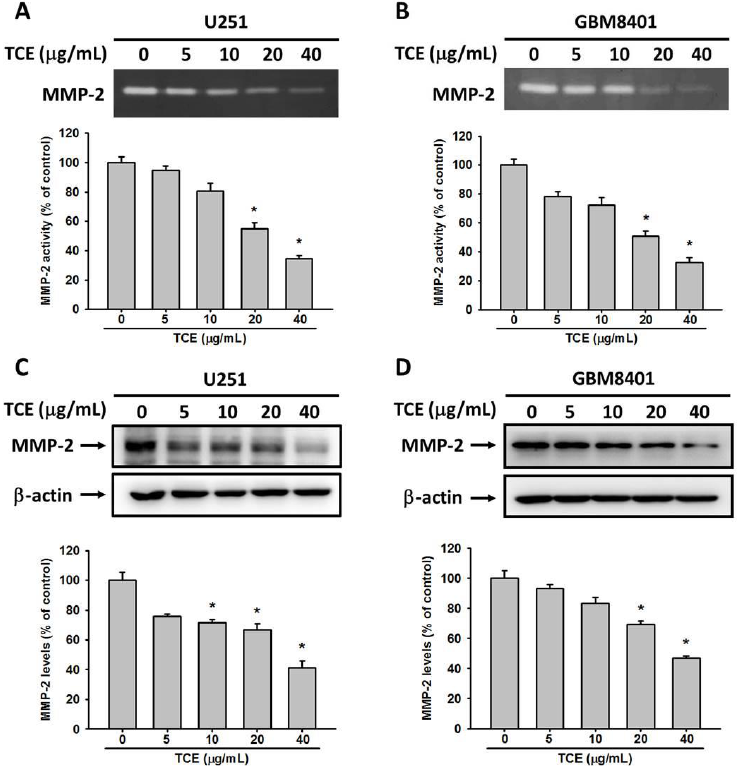
Figure 3. Effects of T. catappa L. extract (TCE) on the enzymatic activity and protein expression of MMP-2. A gelatin zymography assay was applied for the measurement of MMP-2 activity in TCE-treated ( A ) U251 and ( B ) GBM8401 cells (0, 5, 10, 20 and 40 μg/mL). The expressions of MMP-2 protein during the same treatments of ( C ) U251 and ( D ) GBM8401 cells were assessed by western blot. The values represent the means ± SD of at least three independent experiments. * p < 0.05, compared with the vehicle group.